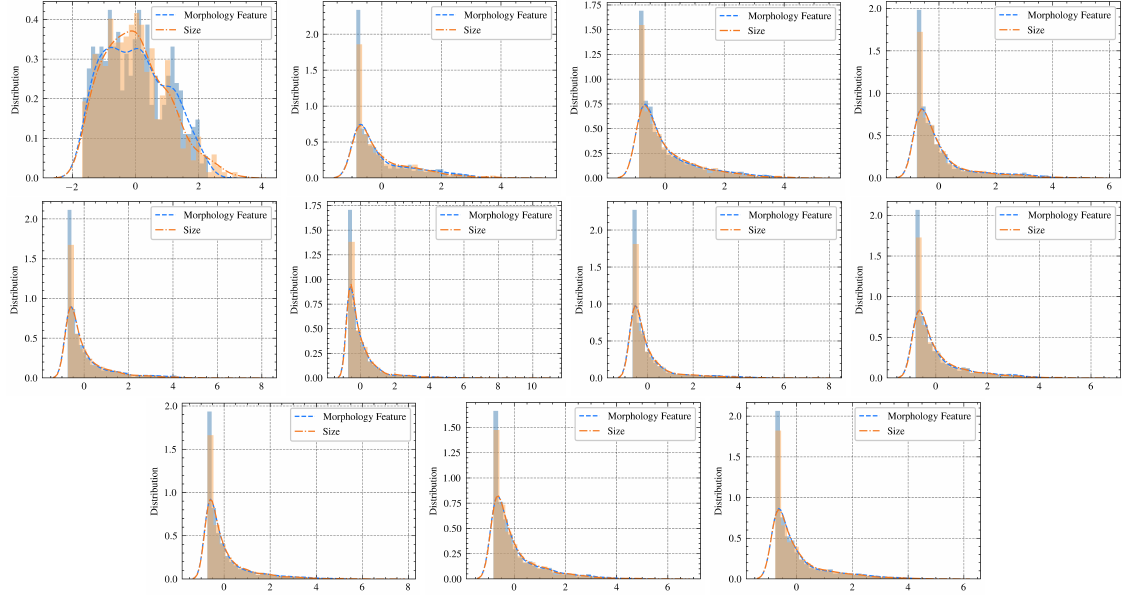
Figure 6. The distribution of grain morphology features and average grain size at each tensile deformation.